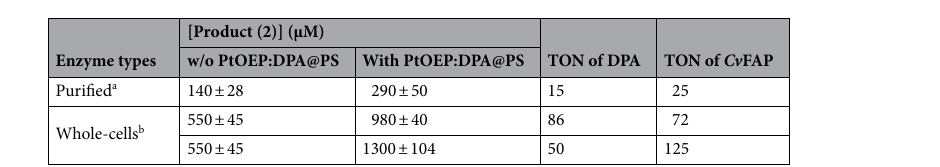
Table 1. Conversion of ricinoleic acid ( 1 ) into ( Z )-heptadec-9-en-7-ol ( 2 ) by Cv FAP under green light. a The reactions were performed by the purified Cv FAP in the absence and presence of the PtOEP:DPA@ PS nanoparticles, which are involved in light upconversion from green to blue light. Reaction conditions: c (Ricinoleic acid) = 5 mM, c ( Cv FAP) = 6 μM, c (DPA) = 10 μM, illumination with green light ( λ = 550 nm). b The reactions were performed by the recombinant E. coli cells expressing Cv FAP in the absence and presence of the PS nanoparticles. Reaction conditions: c (Ricinoleic acid) = 5 mM, c ( E. coli ) = 7.2 g CDW L -1 ( c ( Cv FAP) =